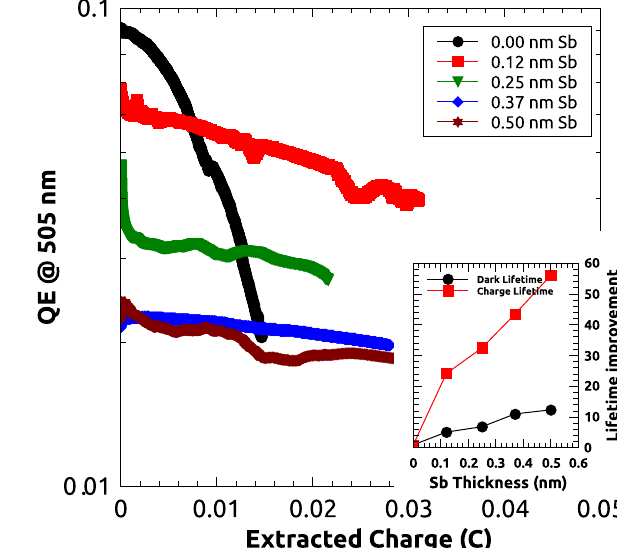
FIG. 5. Measured electron spin polarization for the five samples as a function of the illuminating wavelength. The maximum achievable spin polarization (measured at about 780 nm) decreases as the equivalent thickness of the Sb increases beyond 0.12 nm.